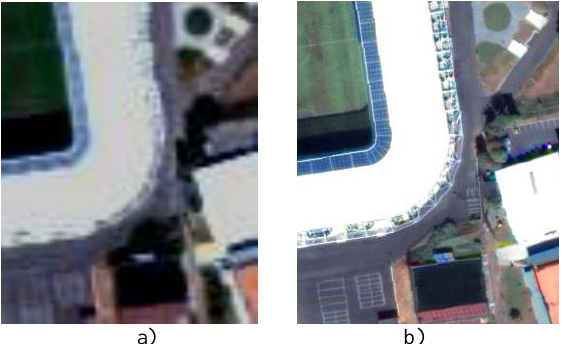
Figure 5. Enlarged fragments of multispectral image (a) input RGB image, (b) fragment of image on Figure